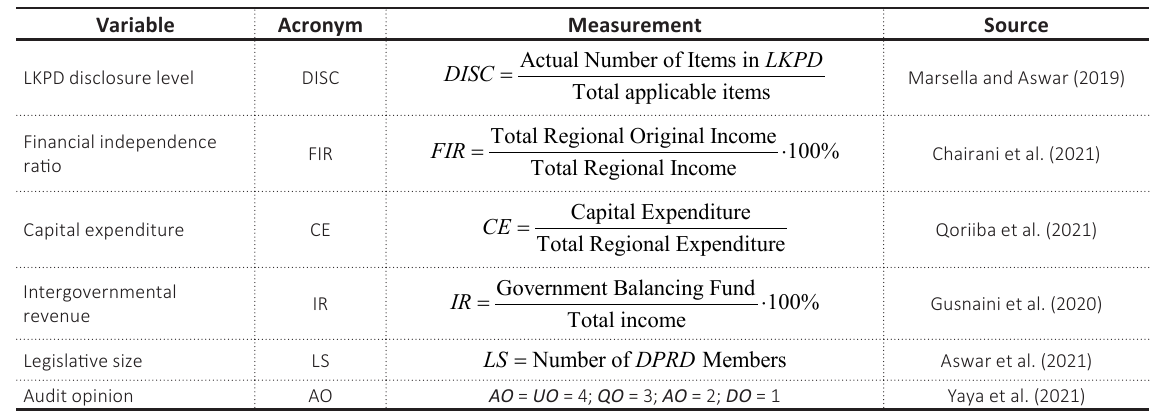
Table 2. Measurement of research